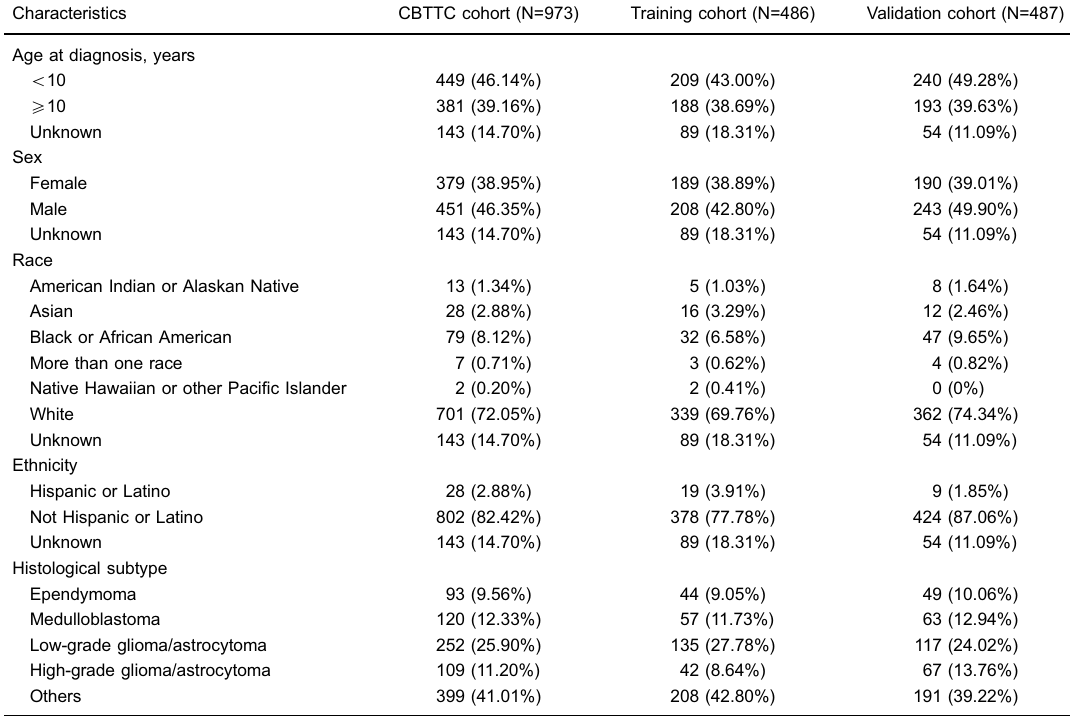
Table 1 . Clinical characteristics of 973 pediatric brain tumor patients involved in the study.